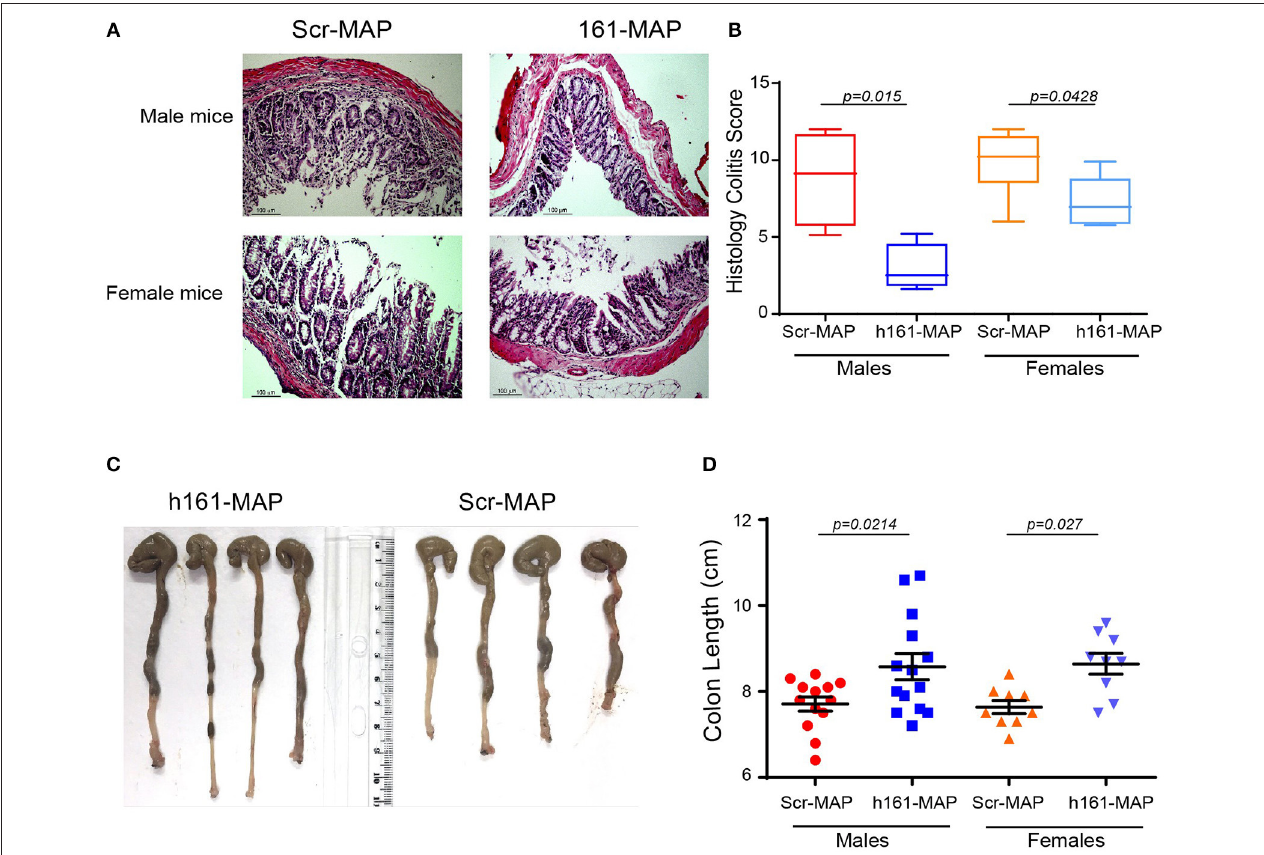
FIGURE 2 | 161-MAP active vaccination prevents damage and extends colon length. Fifteen days after the beginning of DSS-treatment, mice were euthanized and their colons were harvested, formalin-fixed and paraffin-embedded. Colon tissue sections were H&E stained and analyzed for their histological scores. (A) Representative images and (B) the assessment of the histological score ( n = 6 in each group). Scale bar is 100 µ m. (C) Representative images of the entire colon removed from male mice, and (D) measurement of the colon lengths ( n = 12 for the male groups, n = 9 for the female